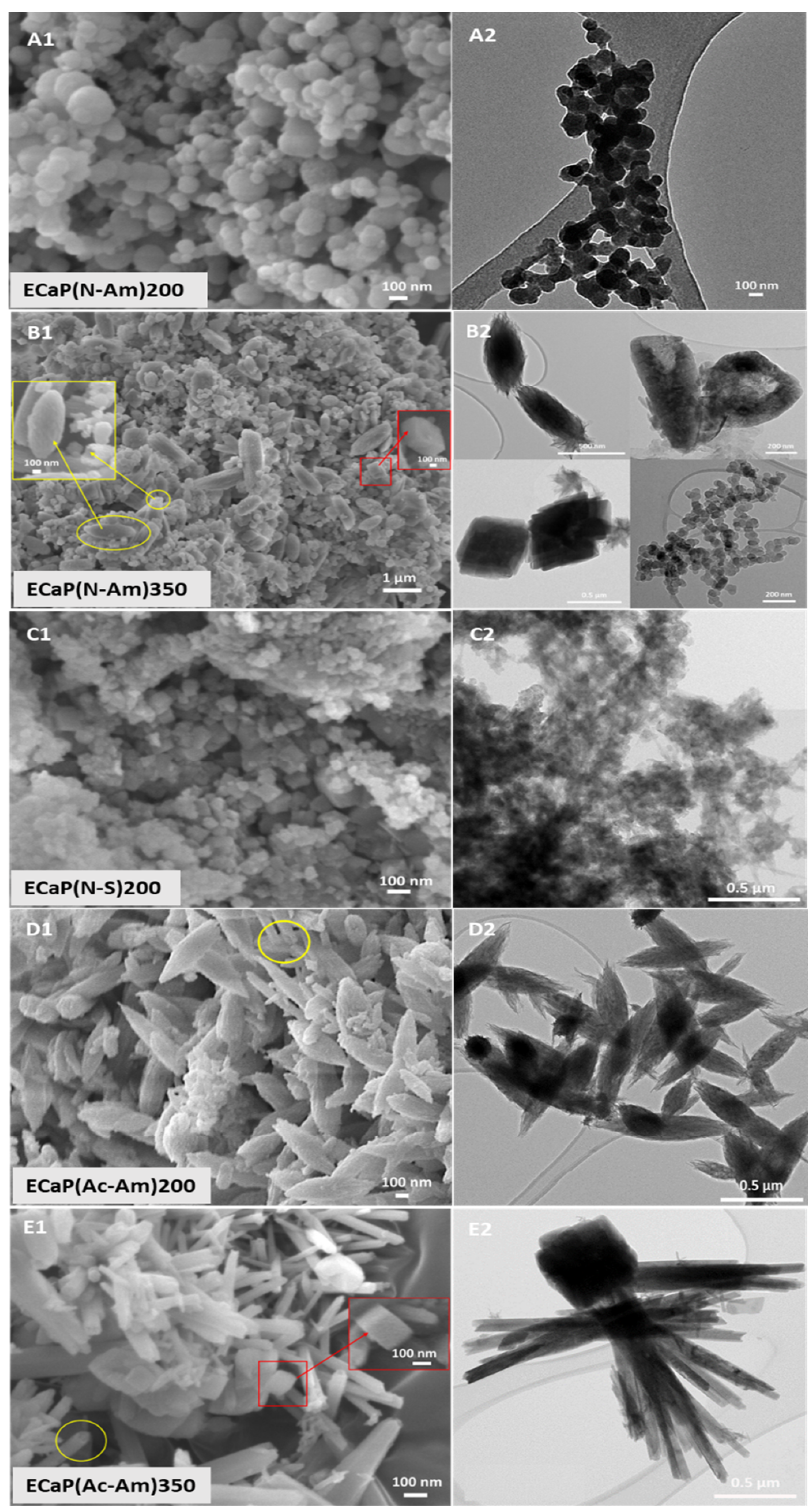
Figure 5. Surface morphology of samples synthesised using eggshell solution (pH = 11) and struvite solution (pH = 6) at 200 °C and 350 °C, where HNO 3 ( A – C ) and CH 3 COOH ( D – E ) were used to dissolve eggshells and struvite, and NH 4 OH ( A , B , D , E ) and NaOH ( C ) were used to adjust the pH of the precursor solutions . The ellipsoidal and rod-shaped HA are highlighted in yellow colour and the rhombohedral-shaped Mg-WH is highlighted in red colour.